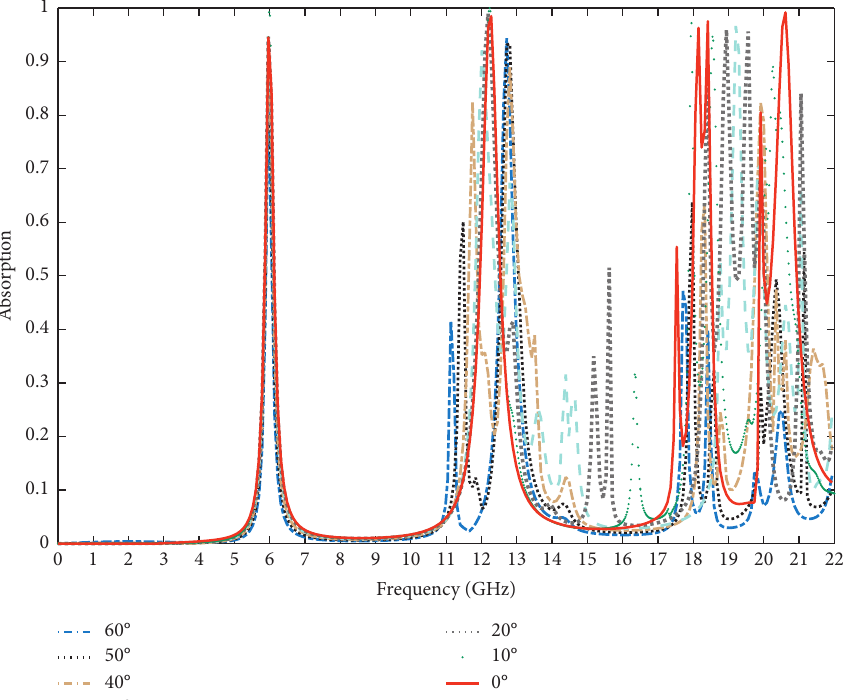
Figure 4: Absorptivity lines at the different incident angles for TE.